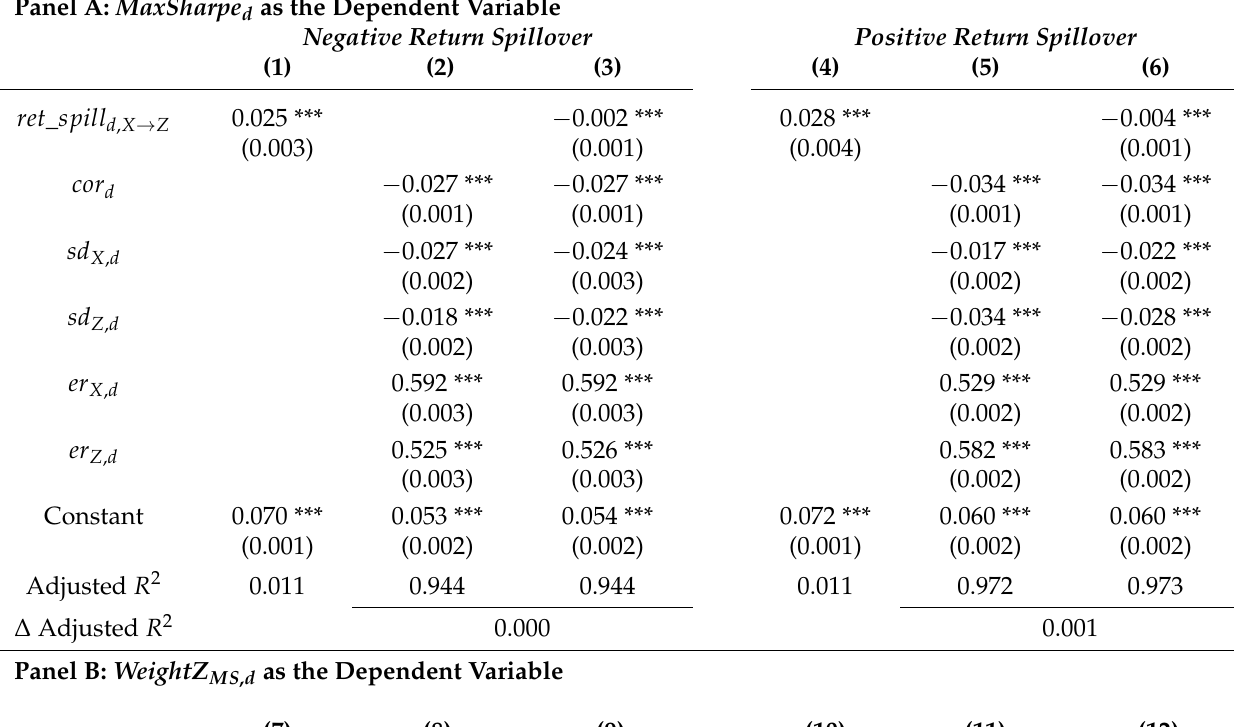
Table 2. Effects of return spillovers on the maximum Sharpe ratio portfolio formed by the same frequency returns. This table presents the results from the regression of the Sharpe ratio (Panel A) and the weight of the spillover-receiving asset (Panel B) of the daily maximum Sharpe ratio portfolio on the daily return spillovers ( ret _ spill d , X → Z ), controlling for daily correlation ( cor d ), daily standard deviation and expected returns of the spillover-giving asset X ( sd X , d and er X , d ) and the spillover-receiving asset Z ( sd Z , d and er Z , d ). We use “daily” for the illustration purpose; the results also apply to any other frequency. The last row in each Panel presents the differences between Adjusted R 2 of the full model and the restricted model without spillovers. Standard errors are in parentheses. *, **, and *** denote significance levels of 10%, 5%, and 1%,